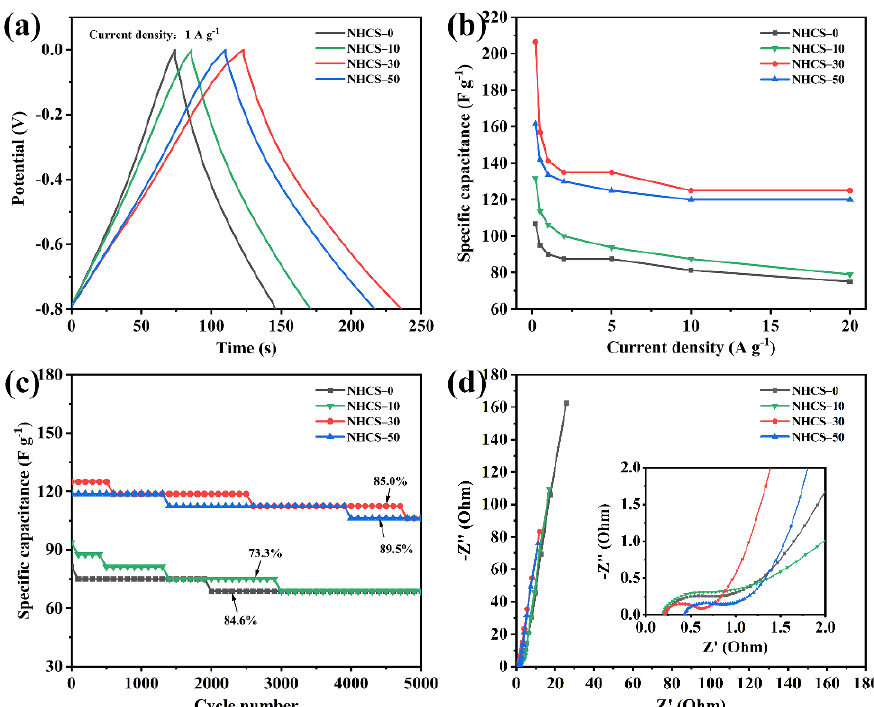
Figure 6. ( a ) GCD curves of the NHCS- m electrodes at a fixed current density 1 A·g −1 ; ( b ) Specific capacitance of NHCS- m calculated by different current densities; ( c ) Cycling stability of NHCS- m measured at 10 A·g −1 ; ( d ) Nyquist plots of NHCS- m .